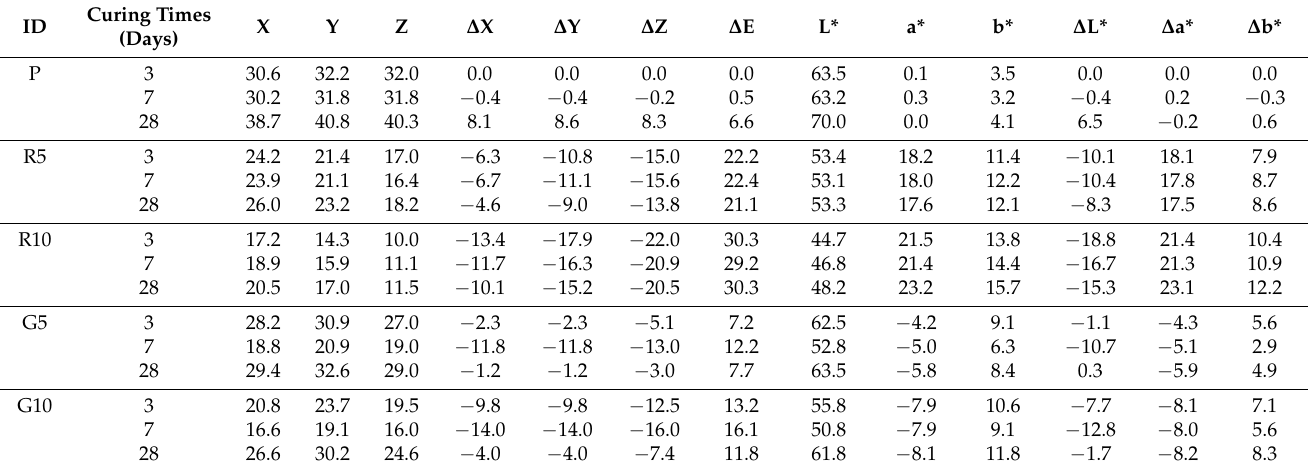
Table 3. Color-difference analysis results of HSCCs.